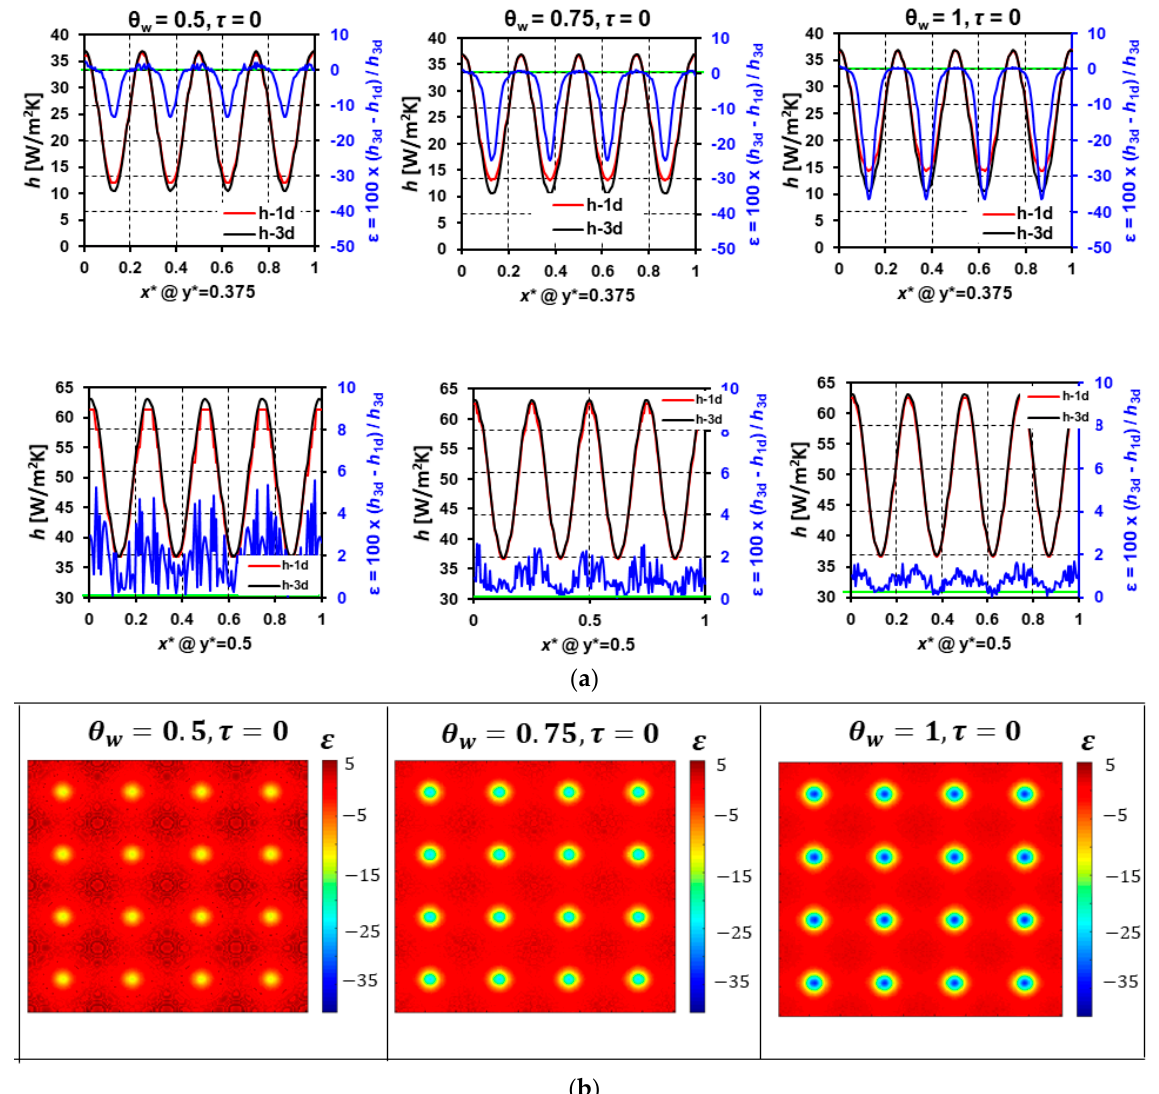
Figure 10. Method B, Case II: ( a ) Local h variation at y* = 0.375 and y* = 0.5 and their relative % differences, ( b ) 𝜀 map for three different wall temperature tracking.